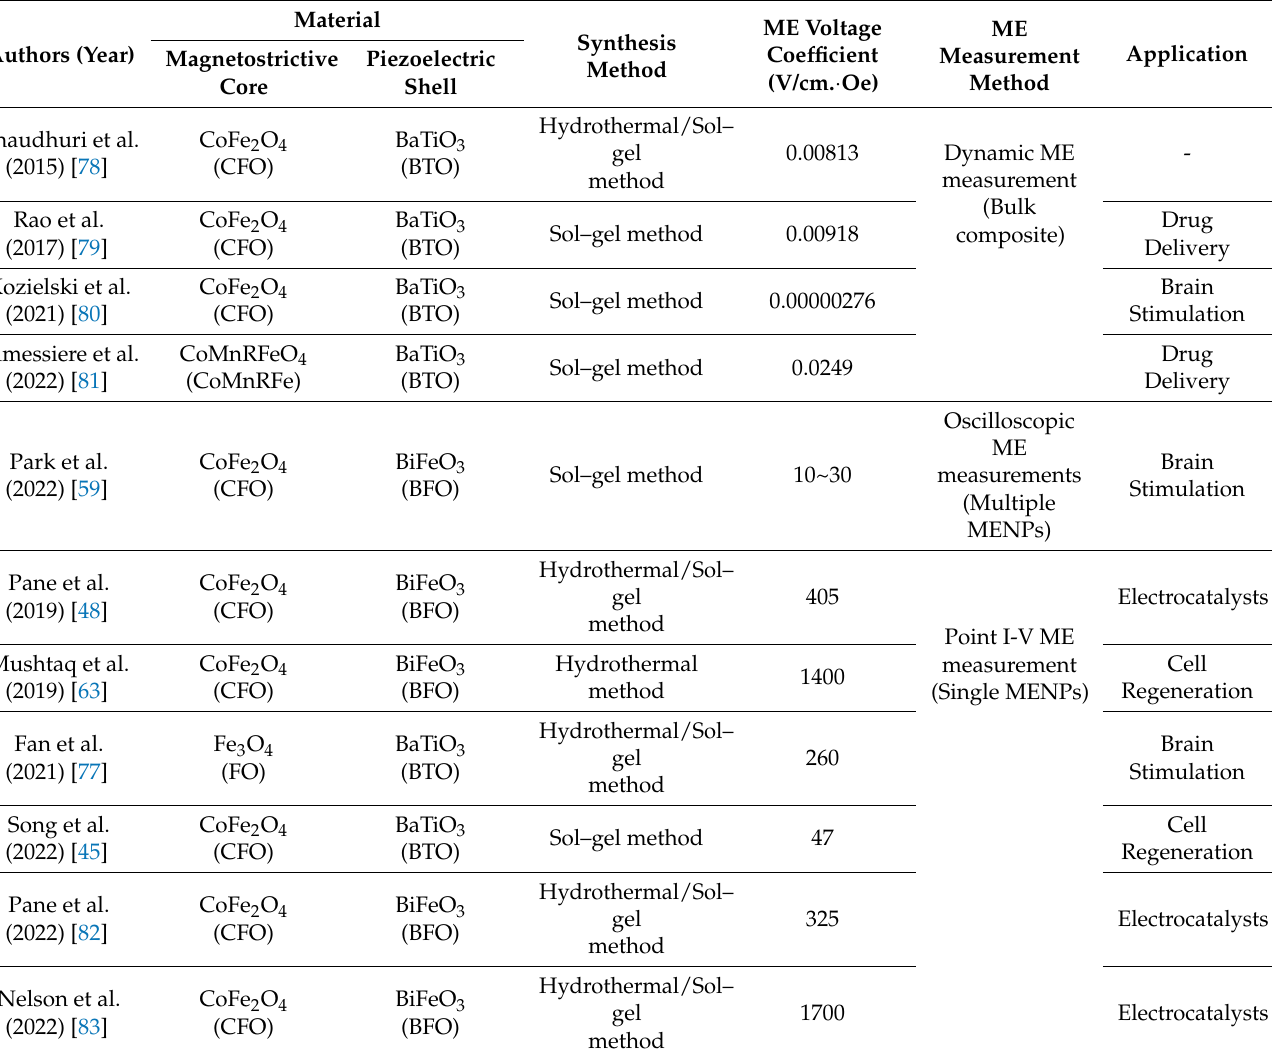
Table 1. Comparison of materials, syntheses, ME voltage coefficients, ME measurement method, and applications of